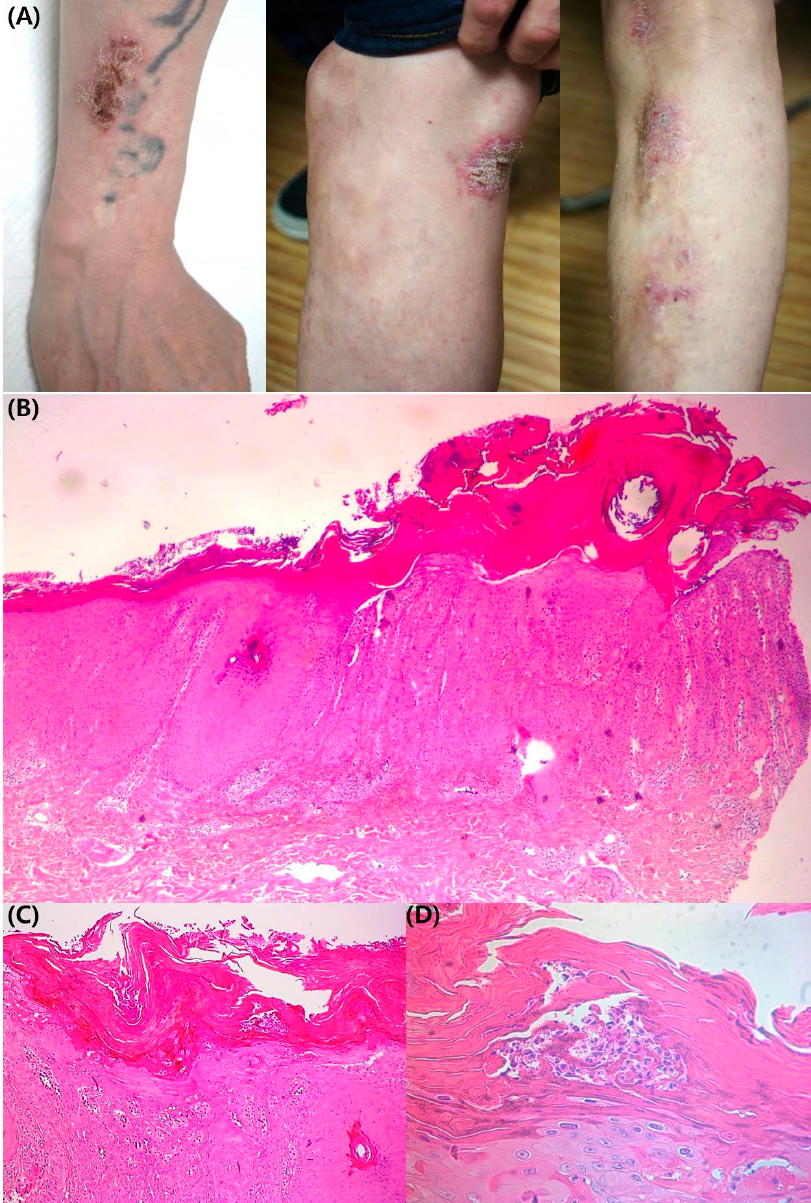
Figure 1. ( A ) Red-brown colored keratotic plaque with crust on the trunk, and both upper and both lower extremities. ( B ) Hyperkeratosis, acanthosis, and rete ridge elongation were present in the epidermis (H&E Scout view). ( C ) Psoriasiform hyperplasia, vasodilatation of the papillary dermis. ( D ) In high- magnification images of the epidermis, Munro’s microabscess with neutrophil dominance and parakeratosis appeared in the stratum corneum (H&E 400 ×